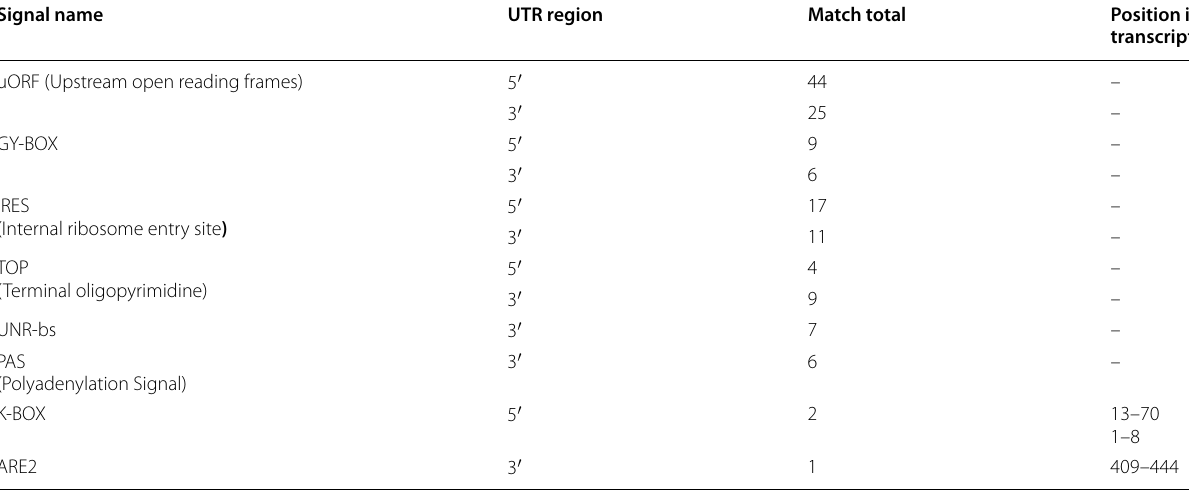
Table 5 Result shows UTR regions in the p53 transcript from the UTRScan server